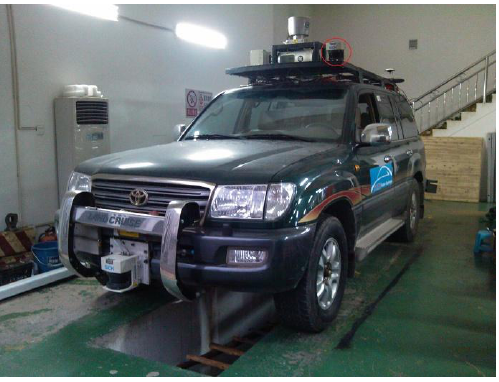
Figure 9. The position of the laser range finder.